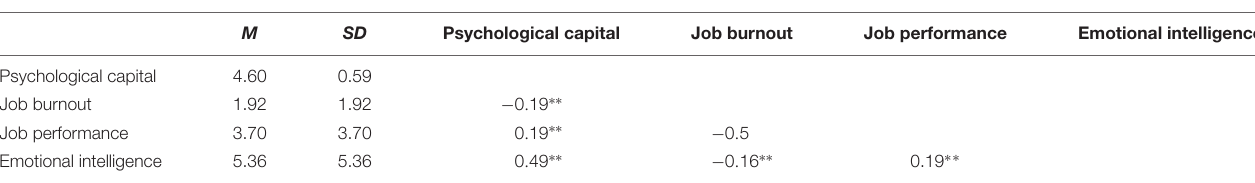
TABLE 4 | Descriptive statistics of main